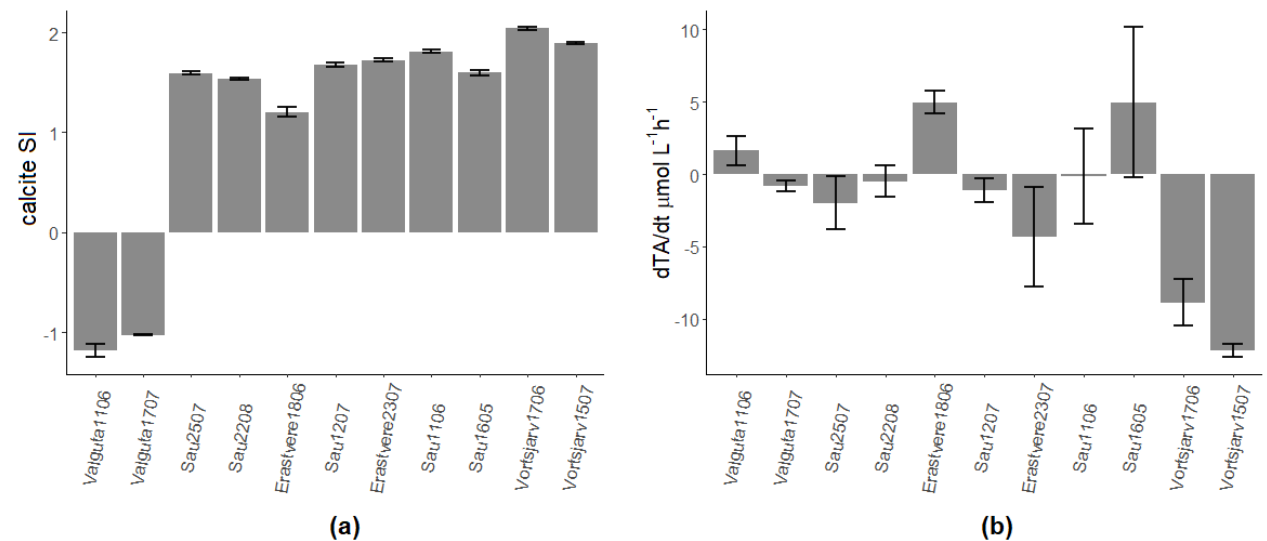
Figure 1. ( a ) Calcite saturation index (SI) in the 11 experimental campaigns. ( b ) Mean ( ± sd) rate of change of alkalinity. Numbers after the name of lakes represent the day and month of sampling; all lakes were sampled in 2019 except for Sau Reservoir in